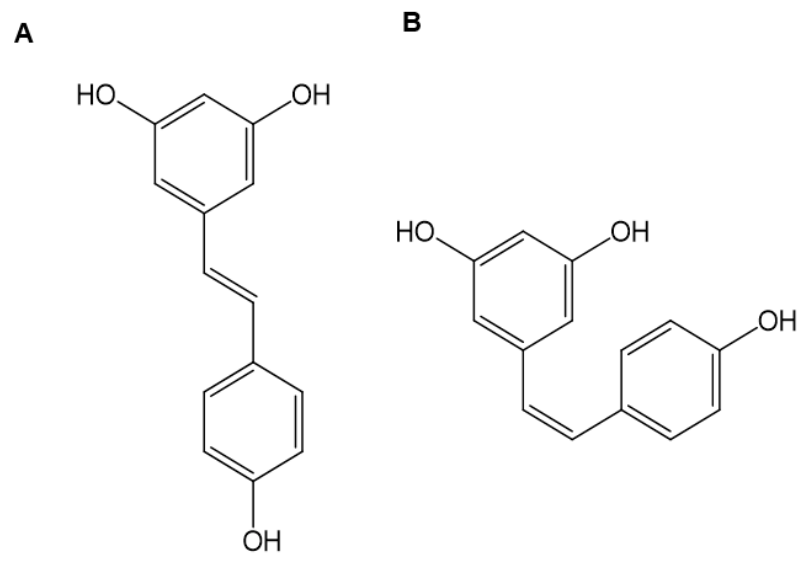
Figure 1. Chemical structures of trans -resveratrol ( A ) and cis -resveratrol ( B ). A chiral phytochemical can stereoselectively modulate P450-catalyzed biotransfor- mation. For example, R -naringenin has a 2-fold more potent inhibition for CYP2C9 and CYP3A inhibition compared with that of the S -enantiomer [25]; (-)-tetrahydropalmatine significantly inhibits CYP2D6-mediated dextromethorphan O -demethylase activity 15 times more extensively than (+)-tetrahydropalmatine [26], and quinidine stereoselectively inhibits CYP2D6-mediated debrisoquine 4-hydroxylation as much as quinine [27,28]. Until now, little information is available on the stereoselective inhibition of RVT on the UGT and P450